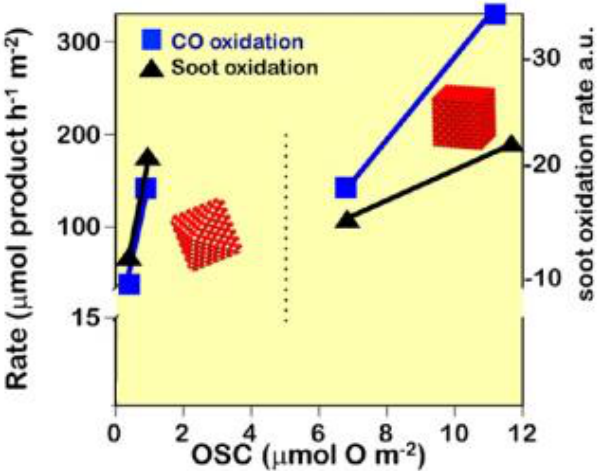
Figure 7. CO and C-soot oxidation rate versus OSC as measured in polyhedral and cubic shaped nanoparticles. Adapted from Refs. [85,86]. Copyright© 2017, American Chemical Society. Copyright© 2014, John Wiley and Sons.